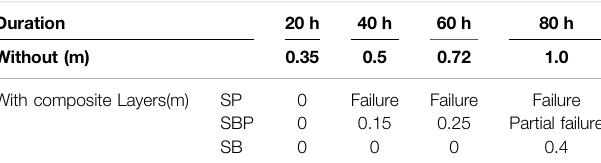
Frontiers in Earth Science |